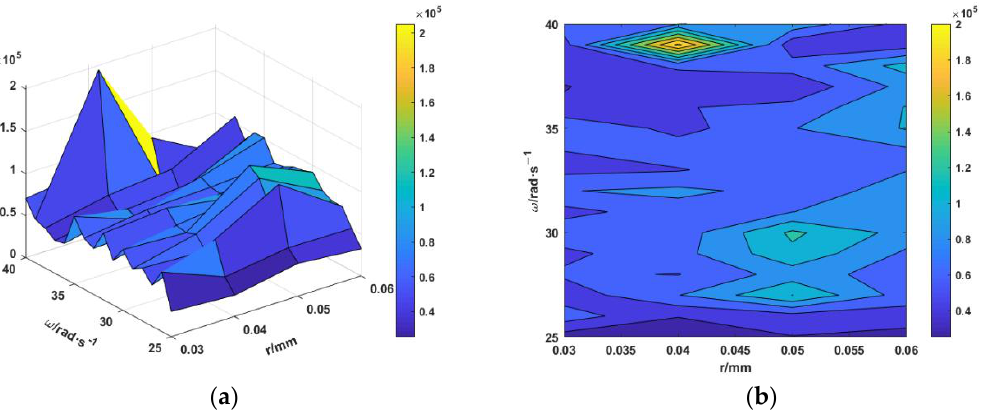
Figure 15. Peak vibration forces on the foundation: ( a ) 𝑟 − 𝜔 − 𝐹 𝑚𝑎𝑥 three-dimensional surface diagram; ( b ) 𝑟 − 𝜔 − 𝐹 𝑚𝑎𝑥 contour map.